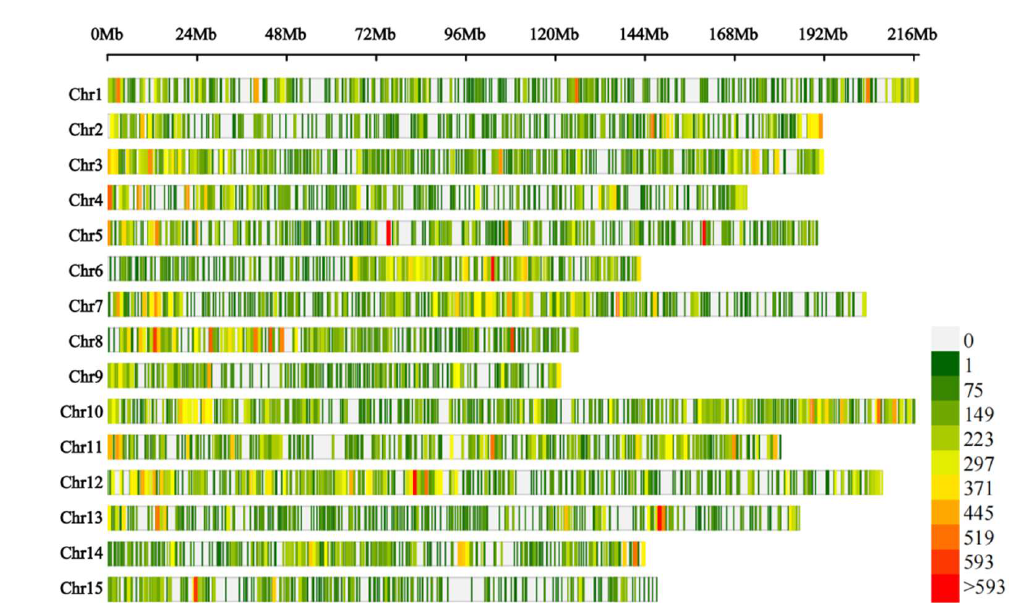
Figure 4. Distribution of variant loci in two seed ratio bulks of C. vietnamensis on C. oleifera var. chromosomes.